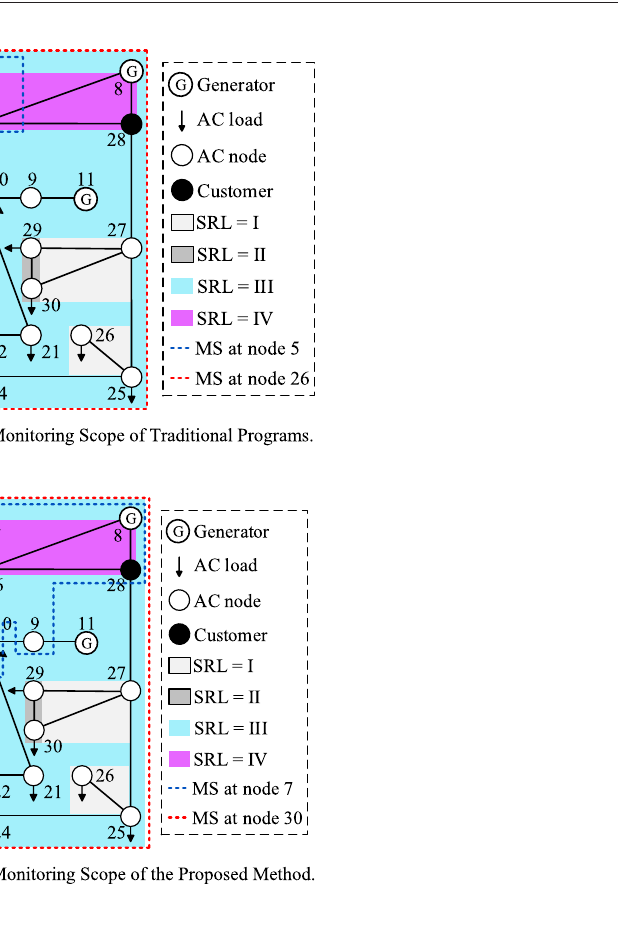
FIGURE 7 | Comparison of the monitoring scope of the two